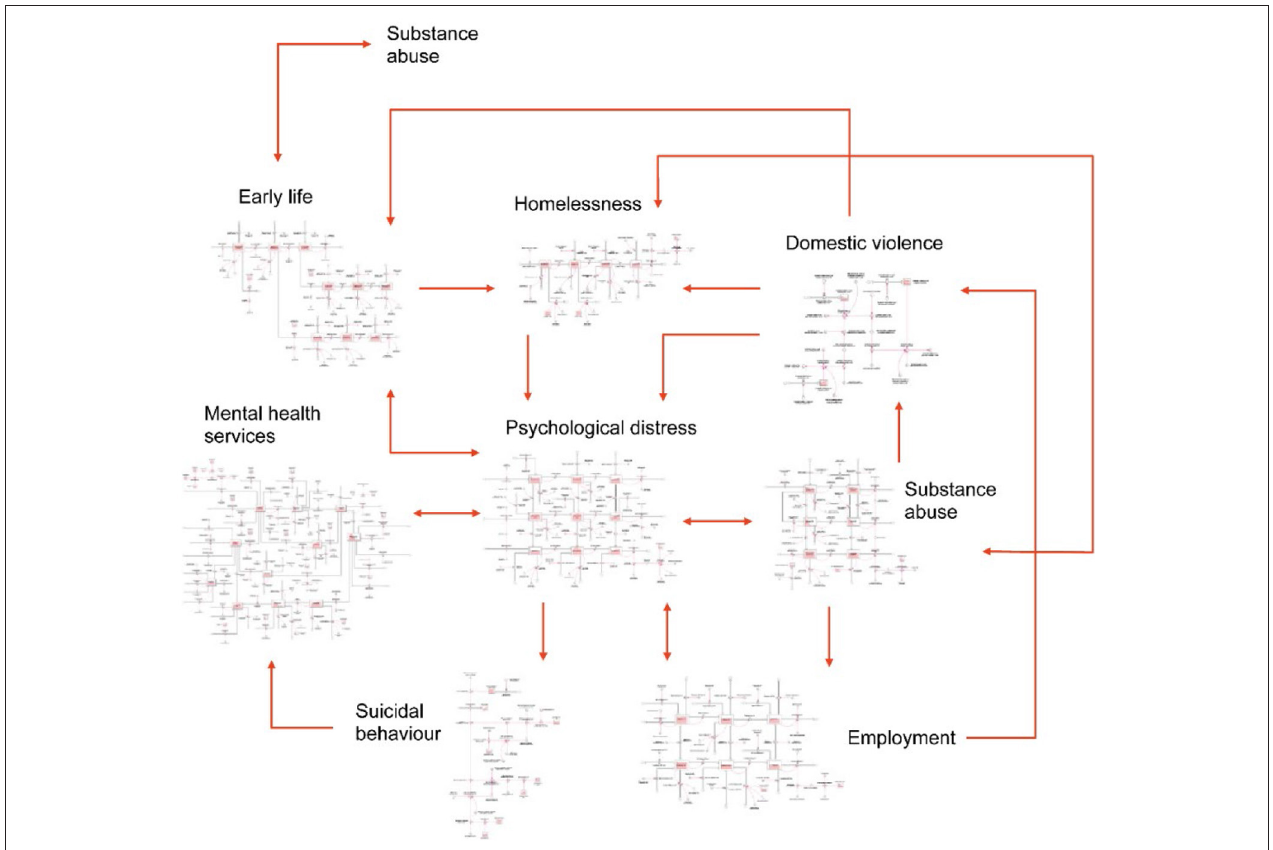
FIGURE 2 | A high-level overview of the causal structure and pathways of one possible model of youth mental health and suicidal behaviour with arrows denoting unidirectional or bidirectional relationships between each component [reprinted with permission